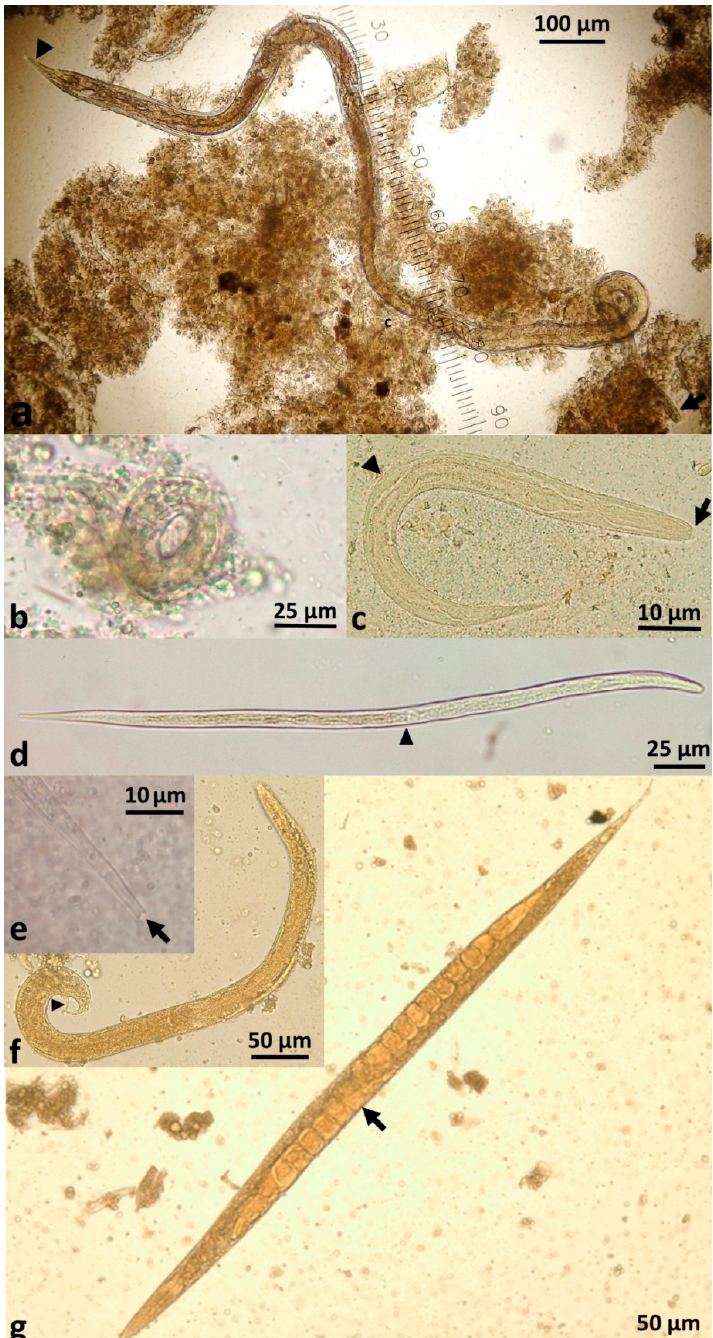
Figure 2. The life stages of Strongyloides stercoralis ; ( a ) parasitic female with tapering anterior (arrow) and pointed caudal extremity (dart); ( b ) embryonated egg; ( c ) rhabditiform larva in faeces with short buccal cavity (arrow) and rhomboid genital primordium (dart); ( d ) filariform larva with oesophago-intestinal junction at mid-body (dart); ( e ) notched tail of the filariform larva (arrow); ( f ) free-living male with prominent spicule (dart); and ( g ) gravid free-living female with eggs in uterus (arrow). Note: Figure 2a,b are from faeces of a patient with hyperinfection; these life stages are not seen in patient faeces in the absence of severe hyperinfection. Figure attributions: ( a , b , e ): Dr Richard Bradbury, Central Queensland University; ( d ): Emeritus Professor John Goldsmid, University of Tasmania; ( c , f , g ): CDC DPDx web site (https://www.cdc.gov/dpdx/). Reproduced with